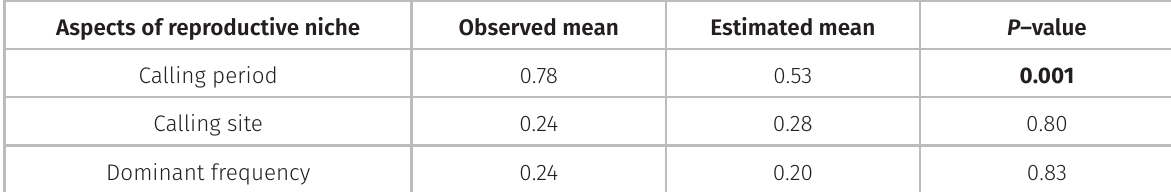
Aspects of reproductive niche Observed